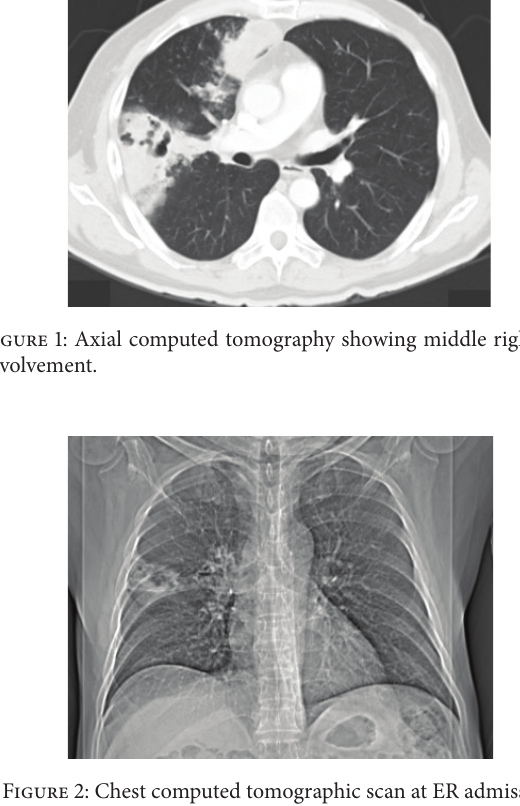
Figure 2: Chest computed tomographic scan at ER